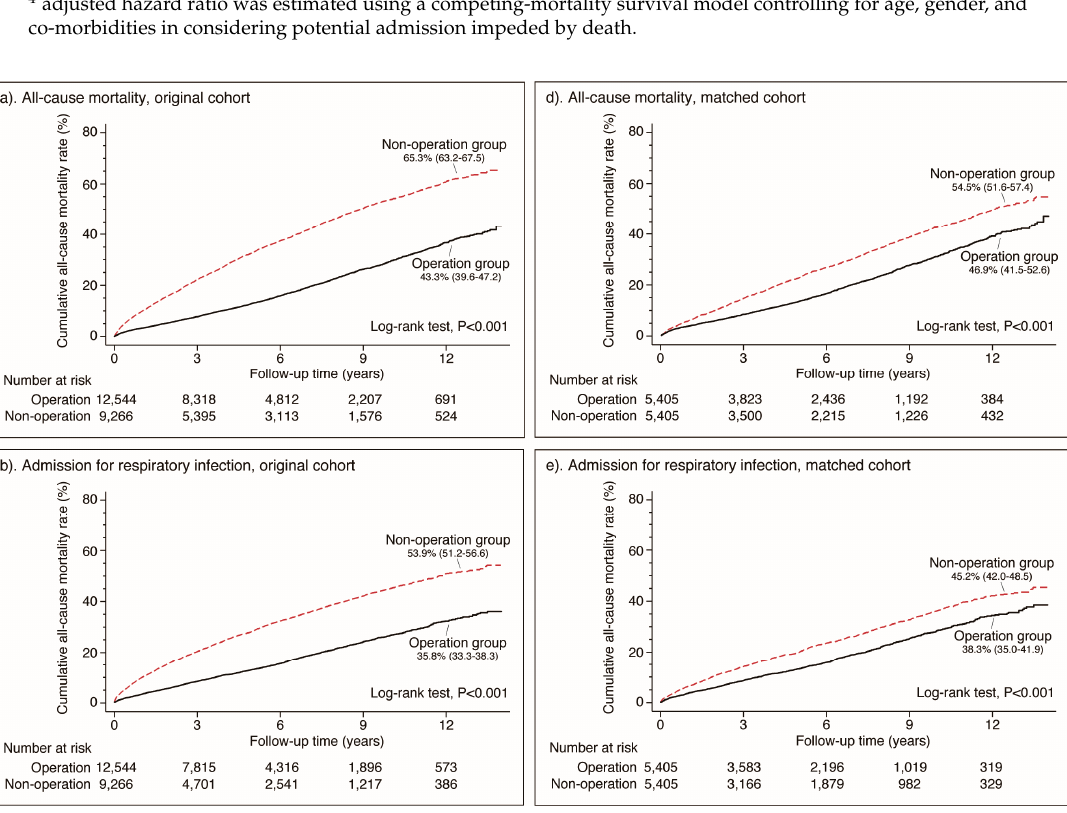
1 Propensity scores were calculated using multiple logistic regression, with sex, gender, and 10 co- morbidities. Patients in the operation and non-operation groups were matched closely with a very low matching tolerance (matching caliber = 0.0001) to evaluate the treatment effect of the operation for spinal deformity; the 2 adjusted hazard ratio was estimated using a Cox proportional hazard model controlling for age, gender, anemia, chronic liver disease, chronic pulmonary disease, congestive heart failure, diabetes, fluid and electrolyte disorders, hypertension, rheumatoid arthritis/collagen diseases, tumor(s), and valvular disease; 3 significance level: ***, p < 0.001; the 4 adjusted hazard ratio was estimated using a competing-mortality survival model controlling for age, gender, and co- morbidities in considering potential admission impeded by death.